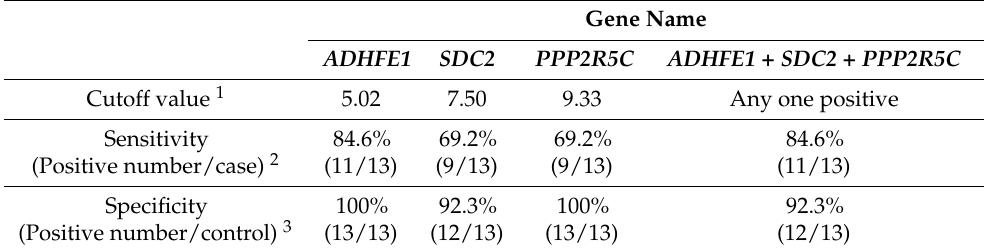
Figure 2. Stool DNA methylation levels of the three candidate genes. ( A ) The dot plots represent crossing point (dCp) values for methylation status of ADHFE1 , SDC2 , and PPP2R5C . The average methylation levels are displayed as horizontal bars in the middle of the scattered dots. (ns: not significant; ***: p < 0.001). ( B ) Area under the receiver operating characteristic curve (AUC-ROC) for the DNA methylation status of ADHFE1 , SDC2 , and PPP2R5C in CRC stool DNA. The cutoff values of dCp of ADHFE1 , SDC2 , and PPP2R5C are 5.02, 7.50 and 9.33, respectively. Table 2. The performance of ADHFE1 , SDC2 , and PPP2R5C for detection of